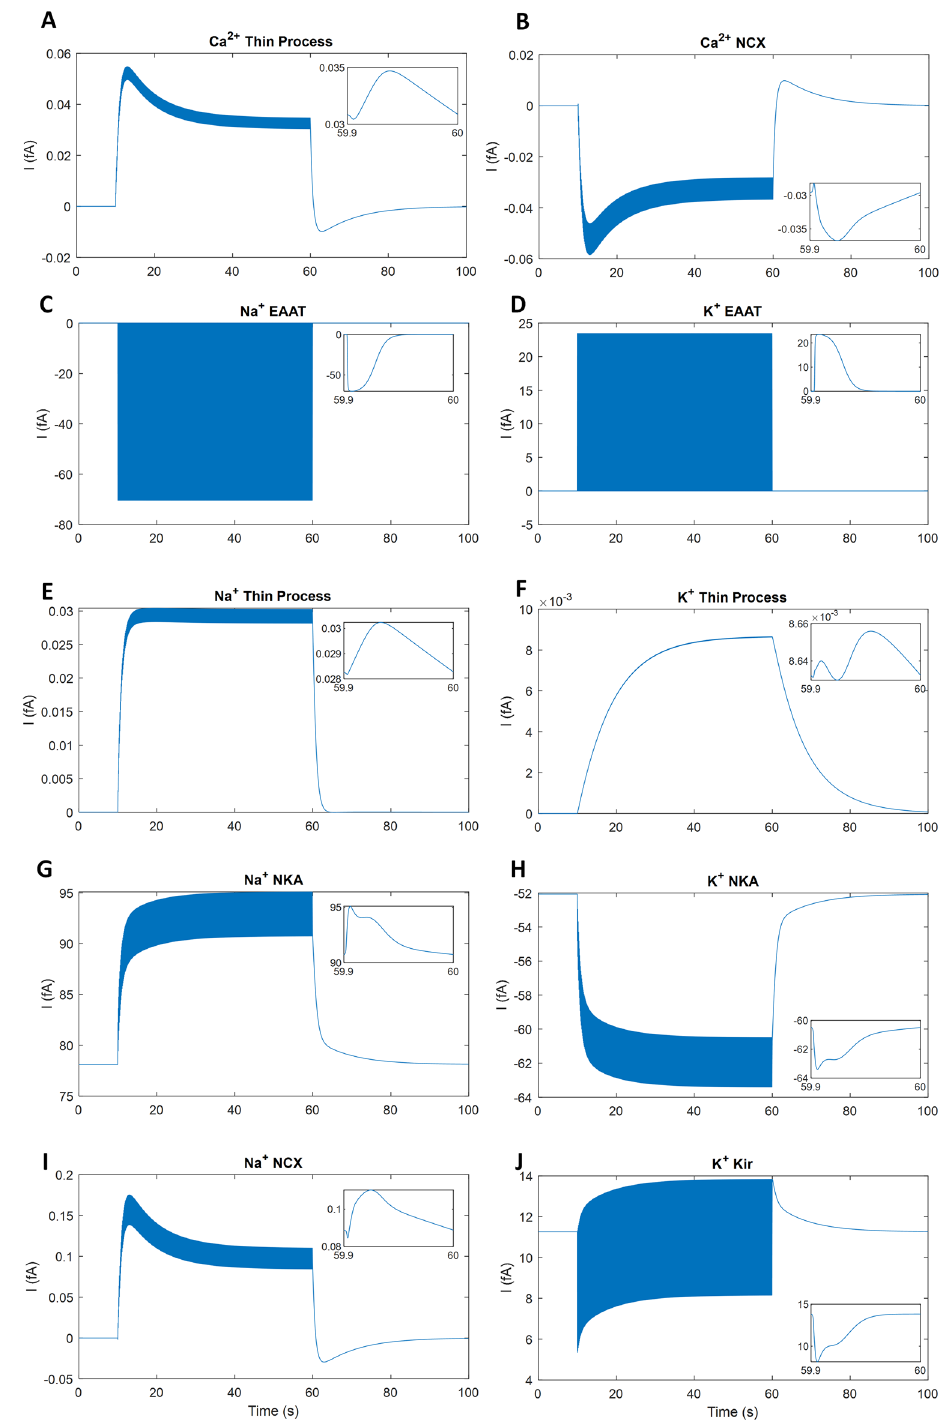
Figure 4. PsC homeostatic response currents. The inset shows the last 100 ms of the stimulus period and all currents are given in femtoamps (fA). The EAAT responds to ECS glutamate by transporting Na + into the cradle ( C ) and transporting K + out from the PsC ( D ). The perturbation of PsC and ECS ionic concentrations drives the NKA pump ( G , H ), NCX exchanger ( B , I ) and K ir 4.1 channels ( J ) to maintain ionic homeostasis. The currents leaving the PsC through the thin process ( A , C , D ) are extremely small in comparison to all other currents. Note the passive background channel currents are not shown although they are included for model stability and completeness. We assume the PsC membrane is semi-permeable to K + , Na + and Ca 2+